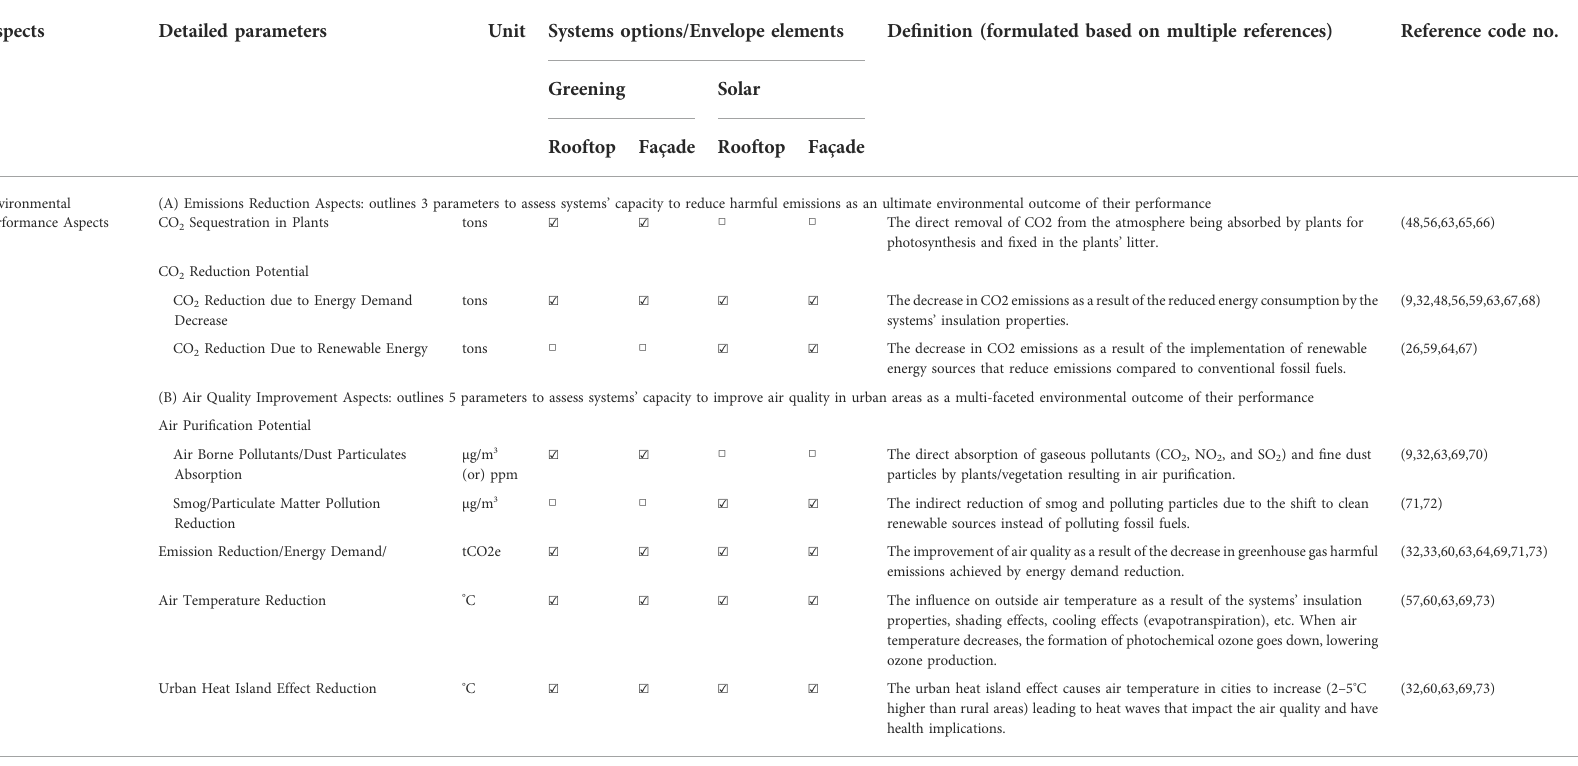
TABLE 2 ( Continued ) Pillar 2 of performance aspects for PBSs Implementation mapped against systems ’ options (greening or solar) on different envelope elements (rooftop or façade). Detailed aspects and parameters were de fi ned for each category, the measurement units, and the de fi nitions are outlined as well. DLI, Daily Light Integral; LAI, Leaf Area Index; PAR, Photosynthetically Active Radiation; CWR, Crop Water Requirements; PVs, Photovoltaic panels; ETTV, Envelope Thermal Transfer